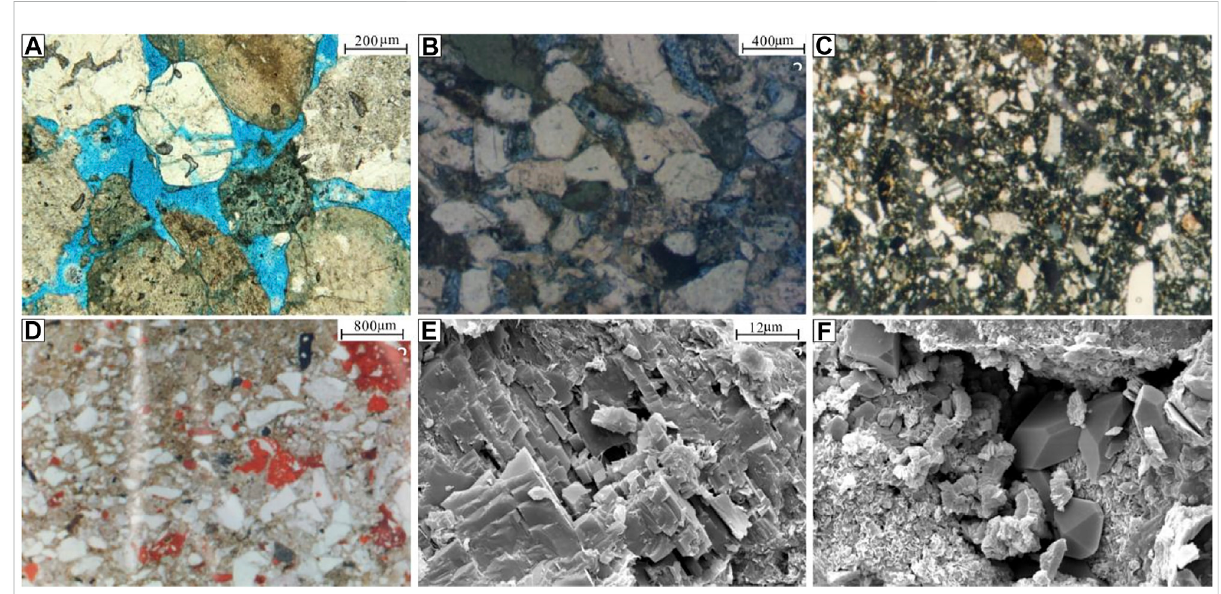
FIGURE 5 (A) . Reservoir space types of the high-deep reservoir of the third member of Shahejie Formation in Gaoshangpu oil fi eld, Nanpu Sag. (A) . GJ3102-8, 3,131.24 m, gravel-bearing medium sandstone in theunderwater distributary channel, with developed primary poresand a small amount ofintergranularandintragranulardissolutionpores,andthethroatsare fl akyandbundledthroats; (B) .G32-30,3,476.1 m,distributaryestuarybar fi ne sandstone, dissolution pores, mold holes, throats are mainly bundled, and fi ne throats; (C) . G58-33, 3629 m, sheet sand argillaceous fi ne siltstone,fewremainingprimarypores,mainlymicropores,andintragranulardissolvedporesintheclay,and fi nethroatsasthemainthroat; (D) .G83- 10,3663.8 m, far sand bar argillaceous fi ne siltstone, basic pores are basically not developed, a few secondary dissolved pores are developed, there are more clay micropores, poor pore permeability, and fi ne throat mainly; (E) . GJ5-44, 3169 m, intragranular dissolution pores of feldspar; (F) . GJ5- 44, 3,164.8 m, remaining intergranular